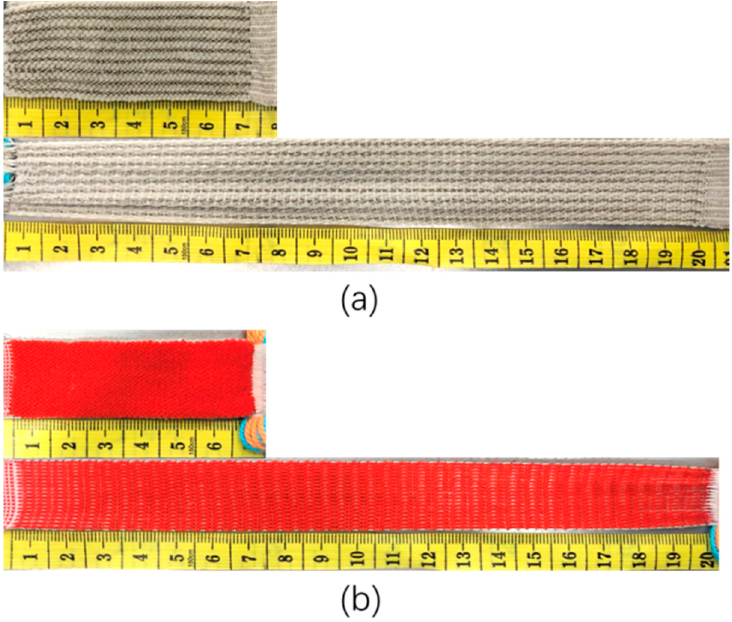
Figure 8. ( a ) Photograph comparison of the 3DWE-TENG (with warp yarn as the electrode) at 0% tensile strain and 300% tensile strain, ( b ) photograph comparison of the 3DWE-TENG (with weft yarn as the electrode) at 0% tensile strain and 300% tensile strain.